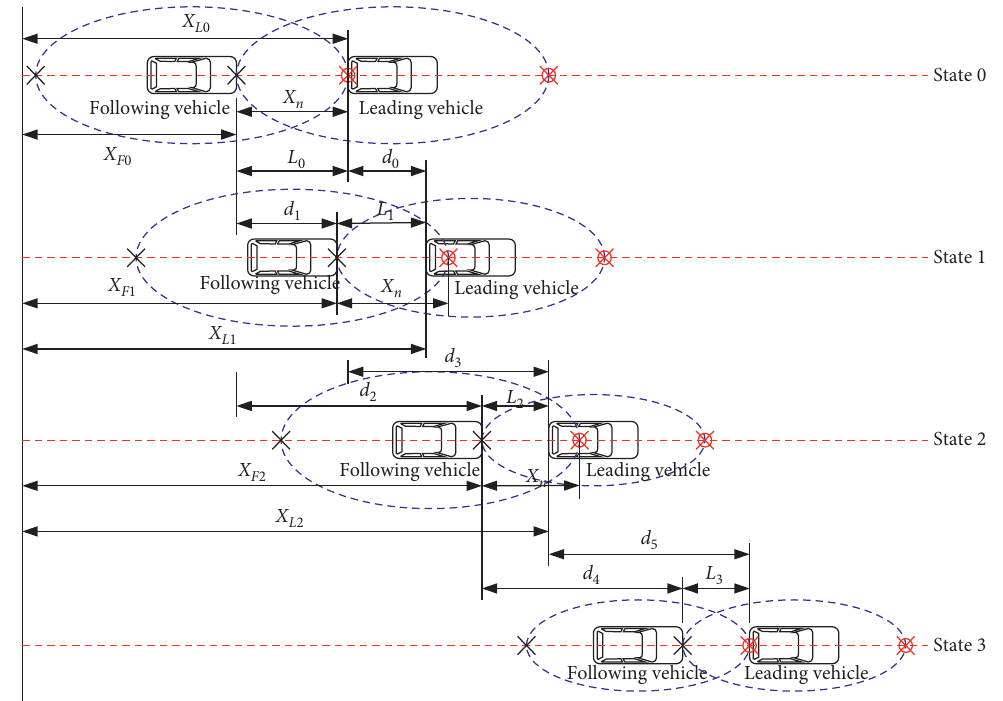
Figure 3: Analytical diagram of speed change of single-lane-following